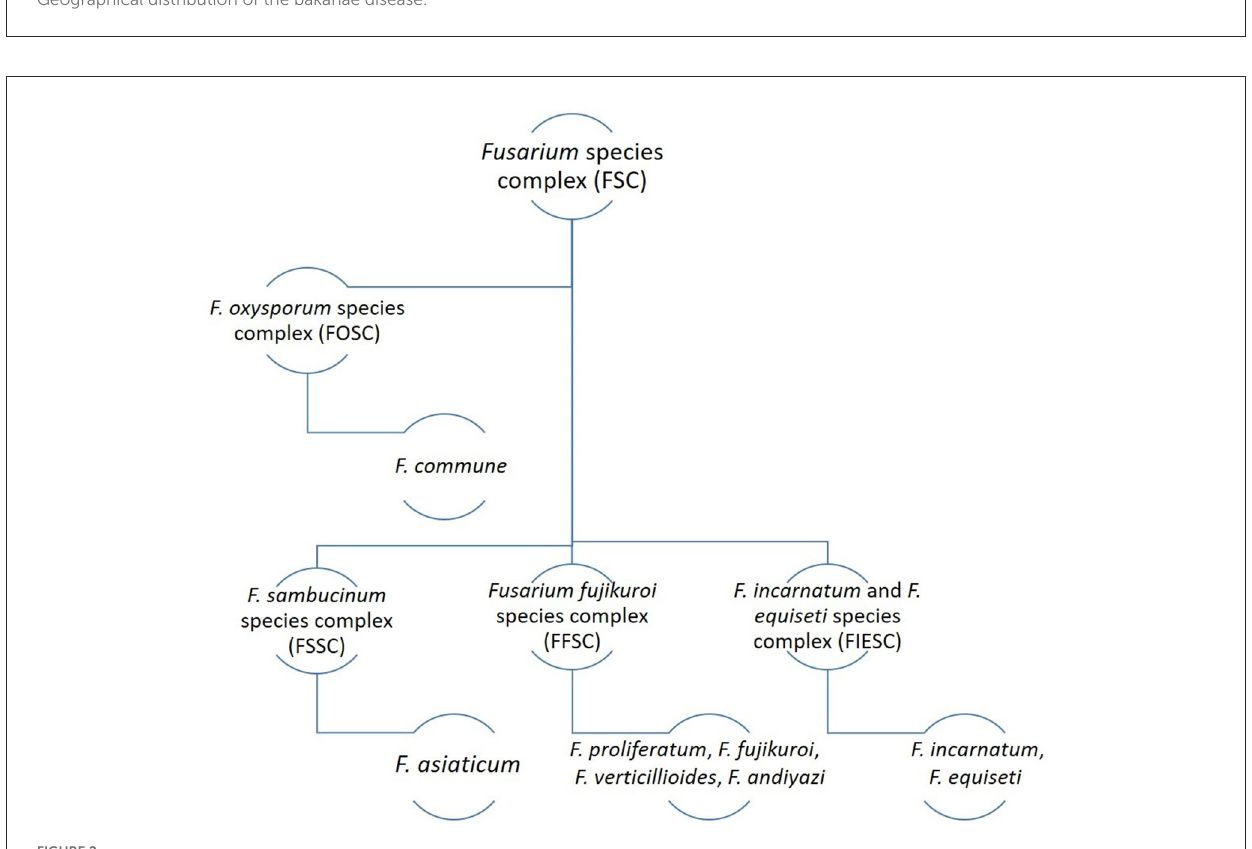
FIGURE2 Fusarium species associated with the bakanae disease of rice.